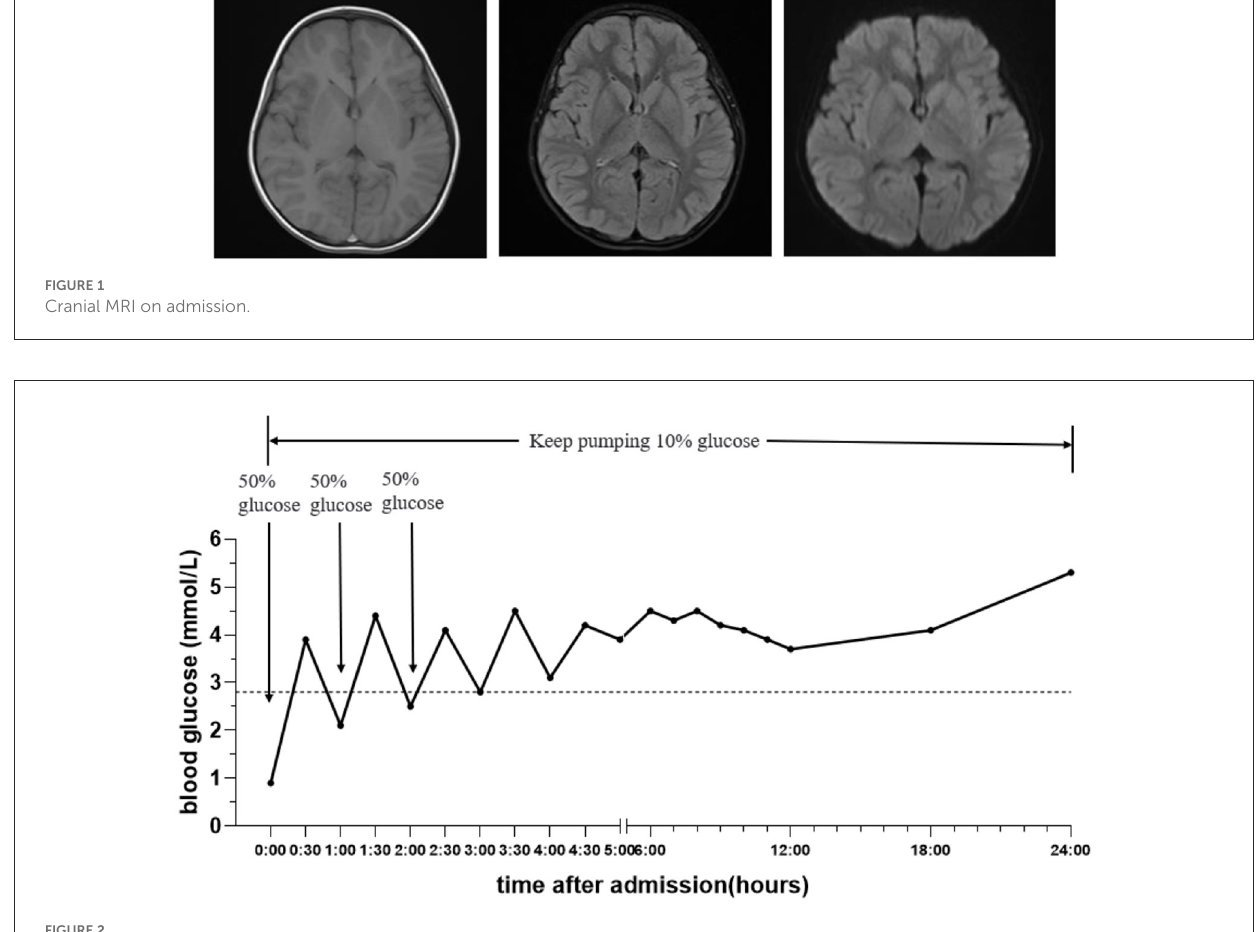
FIGURE2 The changing trend of blood glucose concentration on the 1st day of